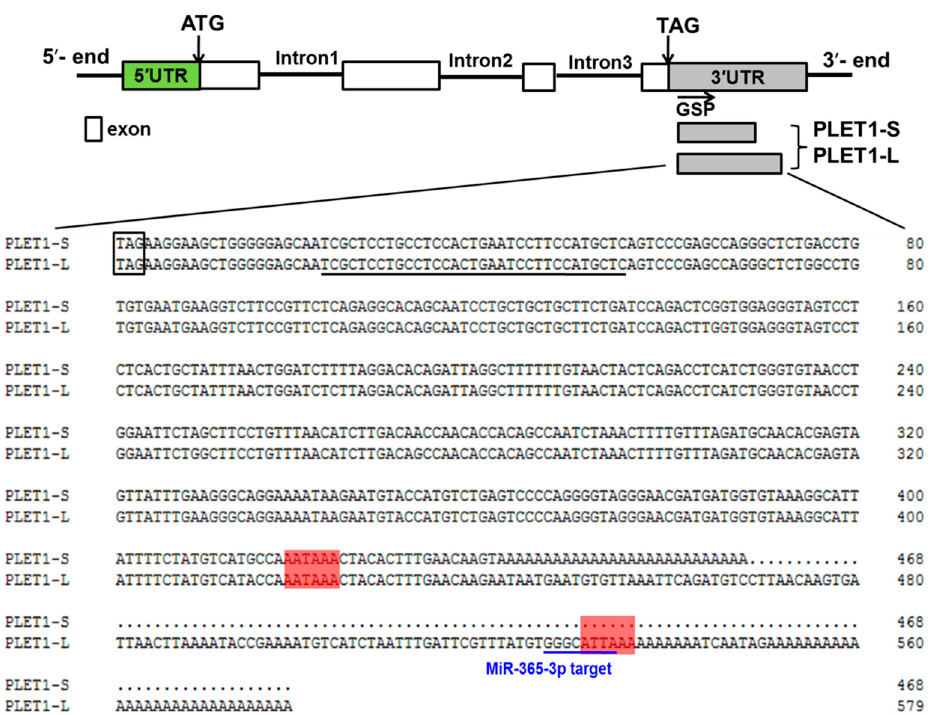
Figure 4. Sequence alignment of the PLET1-S and PLET1-L transcripts. The exons are shown in the box. Primer used for 3 ′ RCAE is underlined (black line). The stop codon is boxed. The two polyadenylation signal sequence (AATAAA and ATTAAA) are highlighted in red. The predicted miR-365-3p binding site is underlined (blue line).